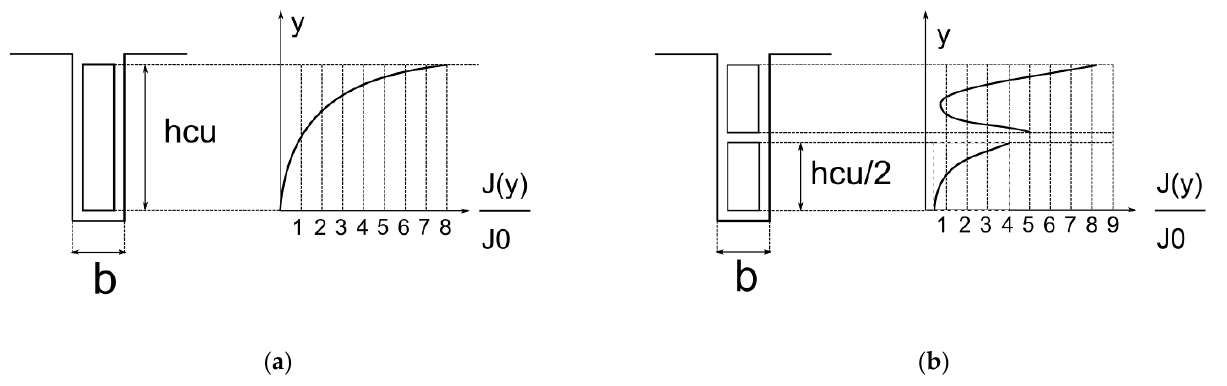
Figure 8. Current density J in the bar ( a ) single bar ( b ) two superimposed bar.